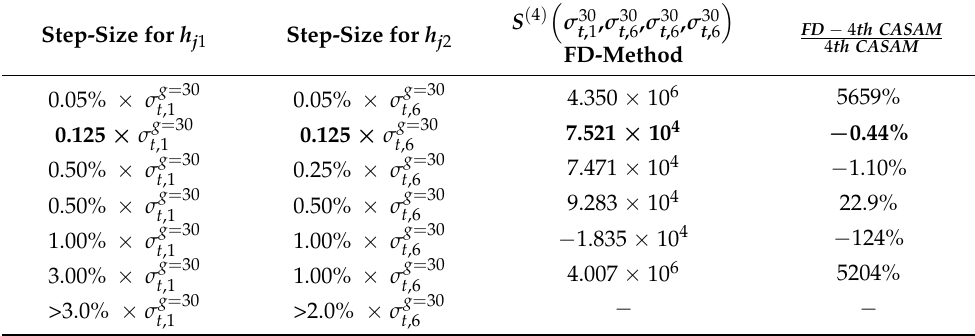
(cid:16) (cid:17) σ 30 , σ 30 , σ 30 , σ 30 using Equation (8) with various t ,6 t ,6 t ,6 t ,1